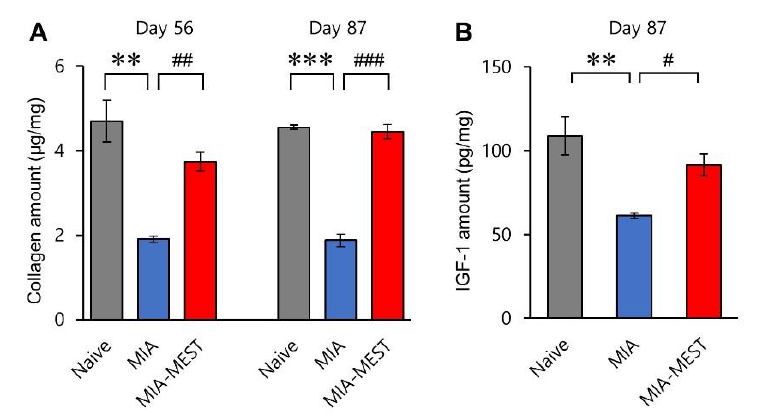
Figure 4. MEST restores MIA-induced decrease in collagen and IGF-1 levels. Local collagen level ( A ). Local IGF-1 levels in RFM on days 56 and 87 ( B ). ** p < 0.01, *** p < 0.001. # p < 0.05, ## p < 0.01, ### p < 0.001. Data are presented as mean ± 95% confidence intervals.